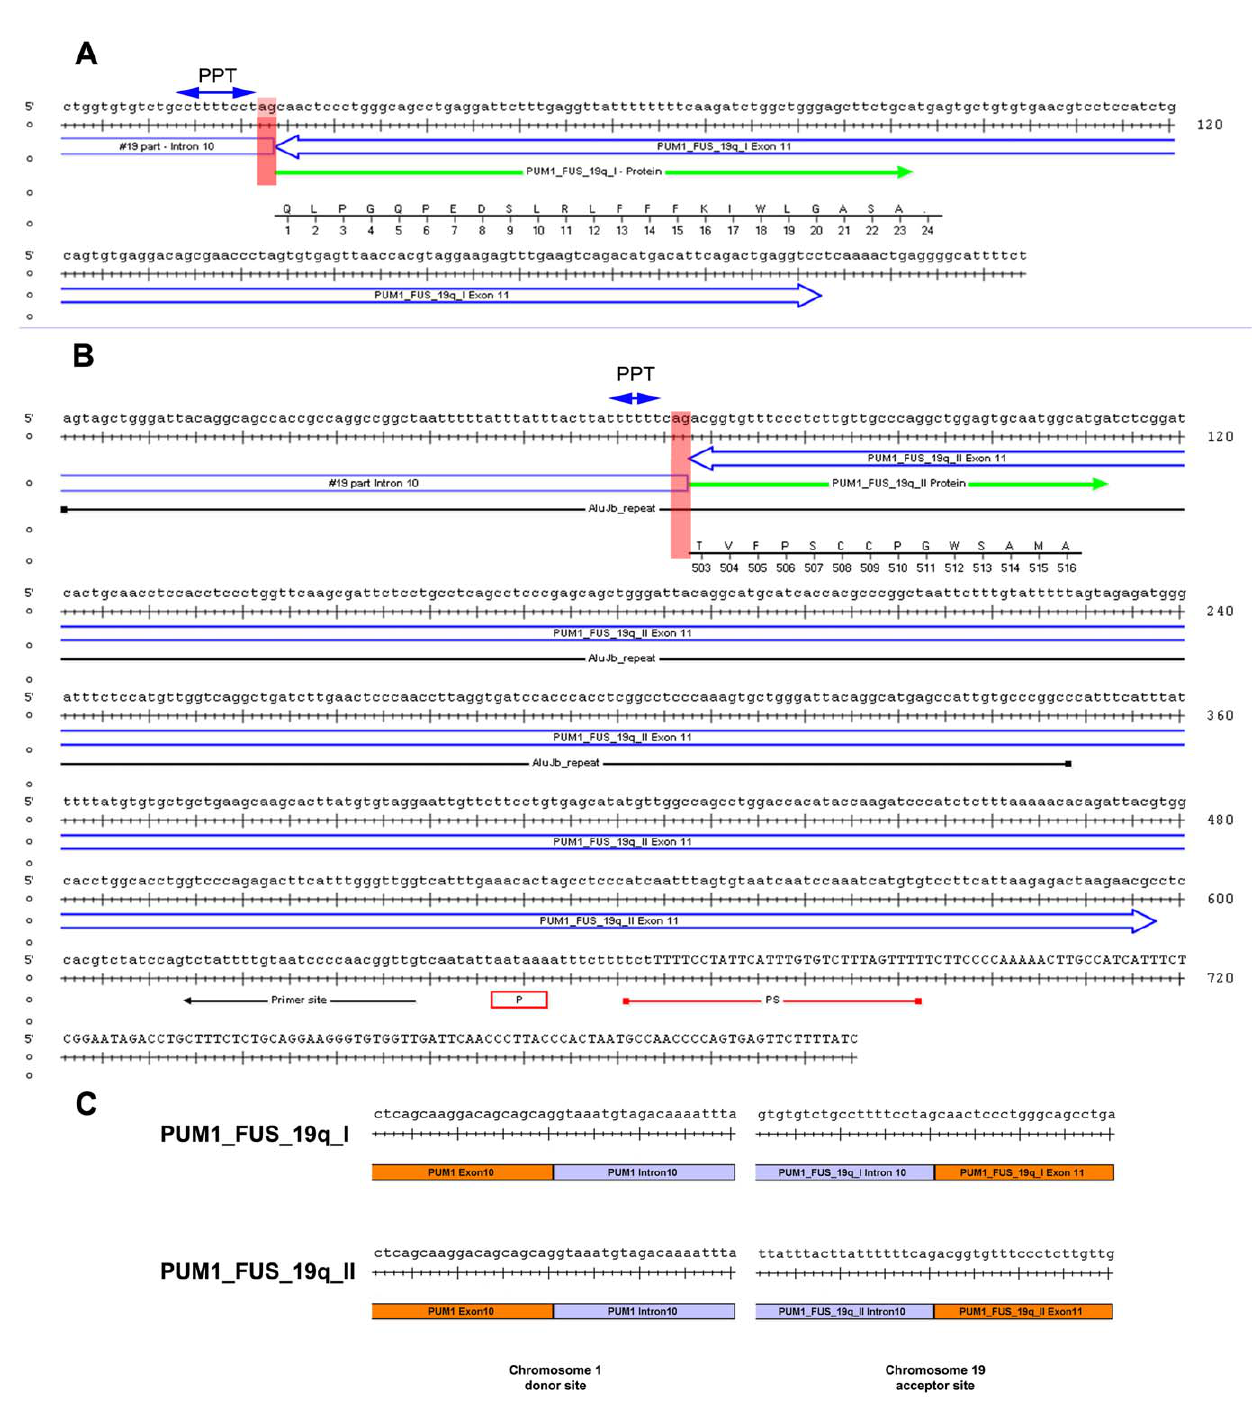
Figure 9. Sequence analysis of the genomic structure of PUM1-FUS-19q. Genomic organization of part of FUS-19q . Blue double arrows indicate exon 11 of PUM1-FUS -19q. The green arrow marks the final part of the fusion protein. The underlying ruler shows the final amino acid sequence. The bases ag (red) correspond to the intron 10 (chromosome 19 part) splice site. Solid blue double arrows indicate the polypyrimidine tract (PPT). A ) Chromosome 19 derived part of the genomic sequence of PUM1-FUS-19q-I . B ) Chromosome 19 derived part of the genomic sequence of PUM1-FUS-19q-II . Black line indicates the Alu–repeat. Site of Primer 500-Cluster_PolyA_I is shown by a black arrow. Red line (PS) and red box (P) indicates predicted poly (A) signals. C ) Intron 10 splice sites of the two PUM1-FUS-19q variants. doi:10.1371/journal.pone.0009485.g009 (PanPath, Budel, Netherlands) referred to as tbpc19 (thyroid Fluorescence In Situ Hybridization (FISH) breakpoint cluster 19q13) was used. The rearrangement probe is Interphase FISH (I-FISH) analyses were performed on touch- a mixture of two probes located distal (3 9 -tbpc19; labeled by preparations of thyroid tumors. For detection of 19q13.4 Alexa Fluor 488) and proximal (5 9 -tbpc19; labeled by Alexa- rearrangements a dual-color, break-apart rearrangement probe